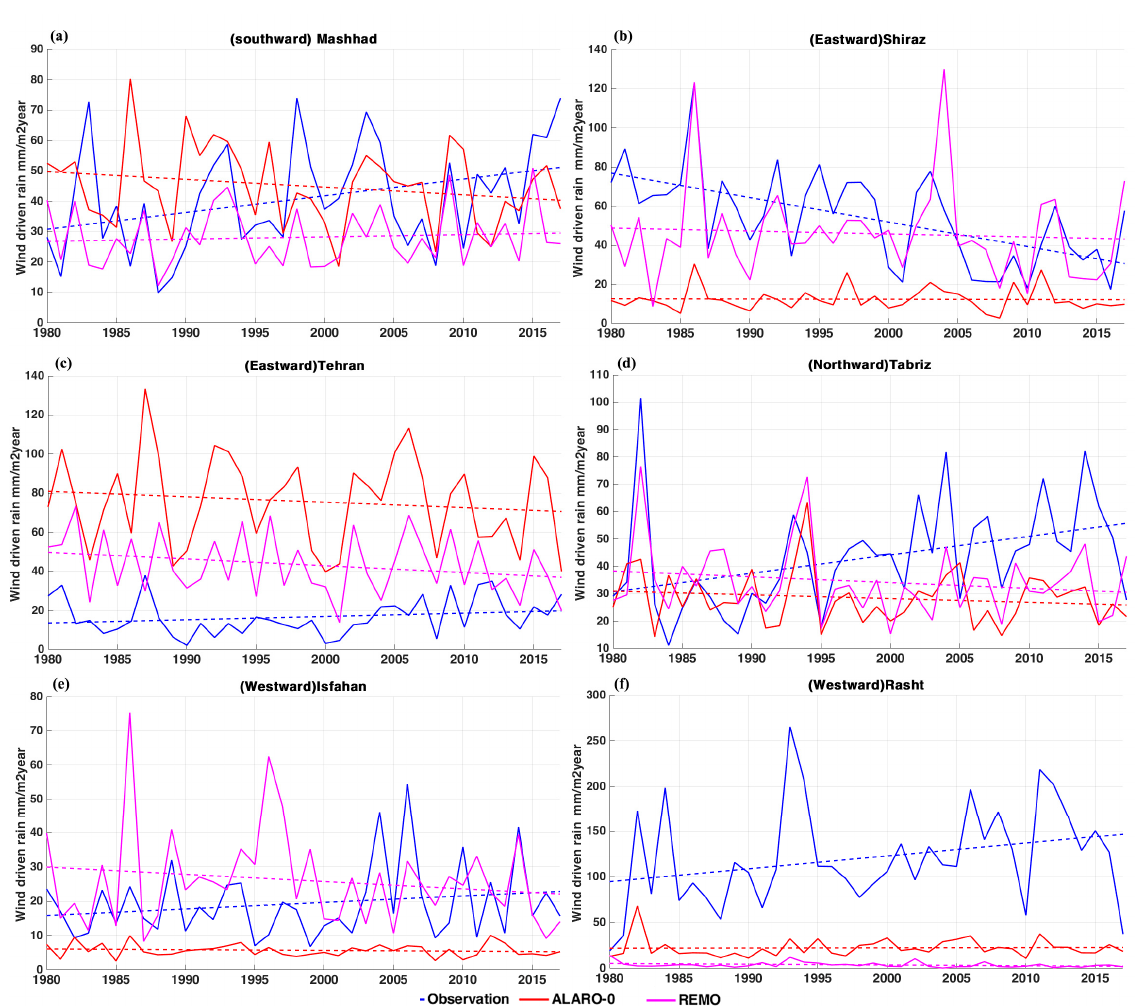
Figure 17. Annual average wind velocity comparing ALARO-0 and REMO with observations over six studied stations: Mashhad ( a ), Shiraz ( b ), Tehran ( c ), Tabriz ( d ), Isfahan ( e ) and Rasht ( f ) during 1980–2017.